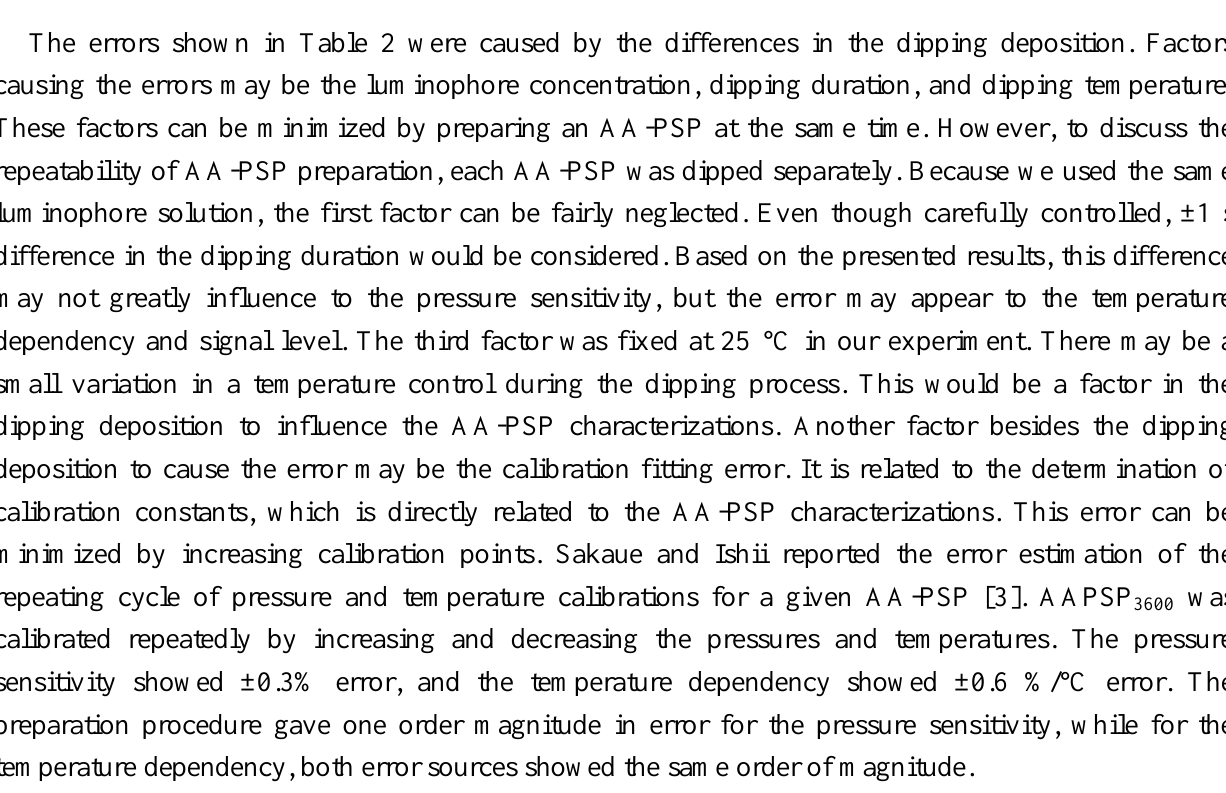
= 1 and others are zero. Condition *2 : 